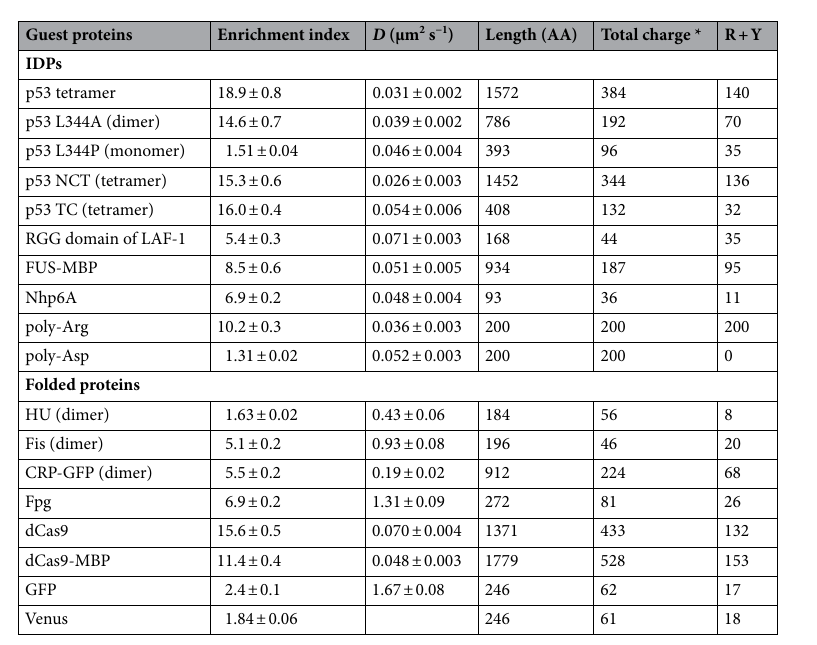
Table 1. Enrichment indices, physical parameters, and diffusion coefficients of guest proteins in the droplets of p53 tetramer. *The total charge number was calculated as the number of R, K, D, and E.